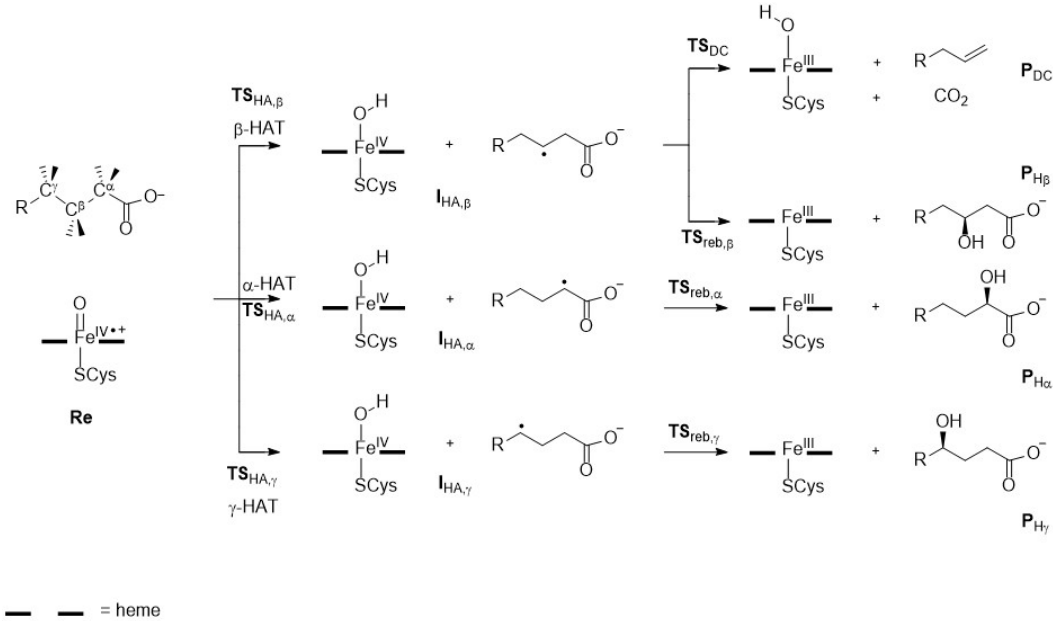
Scheme 3. Reaction mechanism with the definition of transition states and local minima for fatty